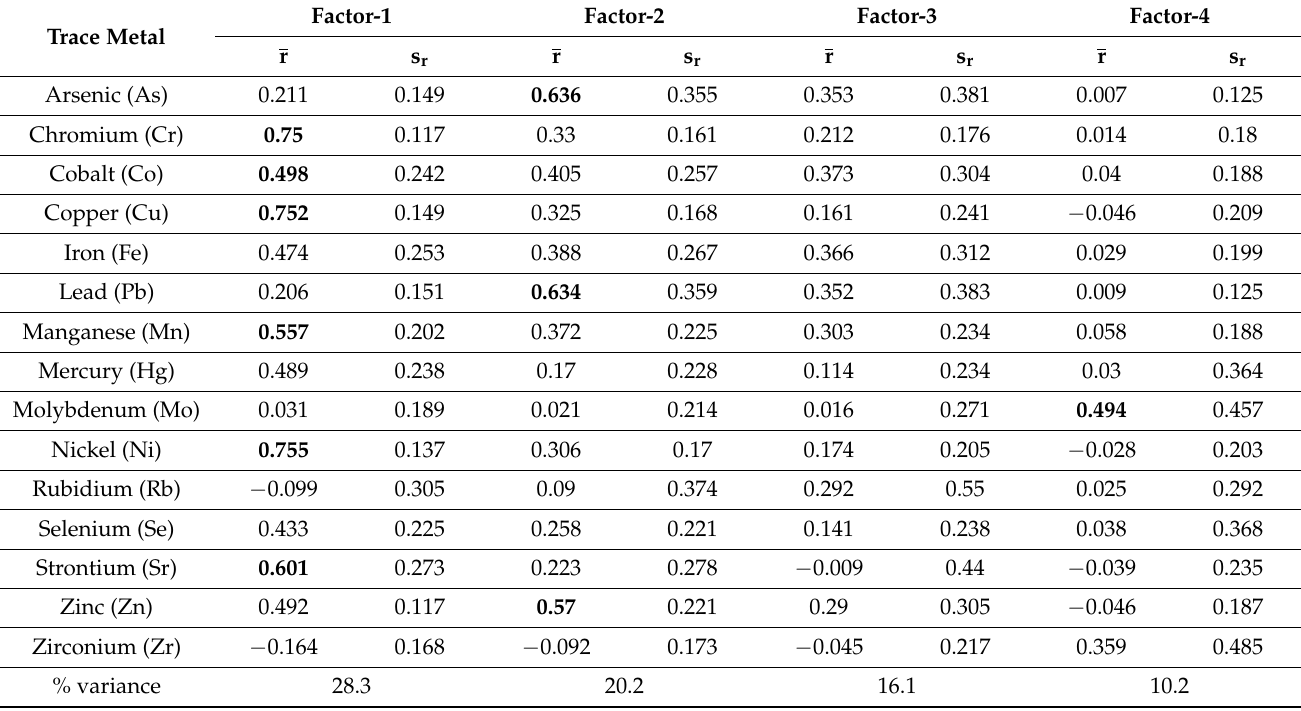
Table 8. Syracuse trace metal induced beta distributed measurement error varimax-rotated factor dimensions: census tract averaged soil sample data (10,000 replications).